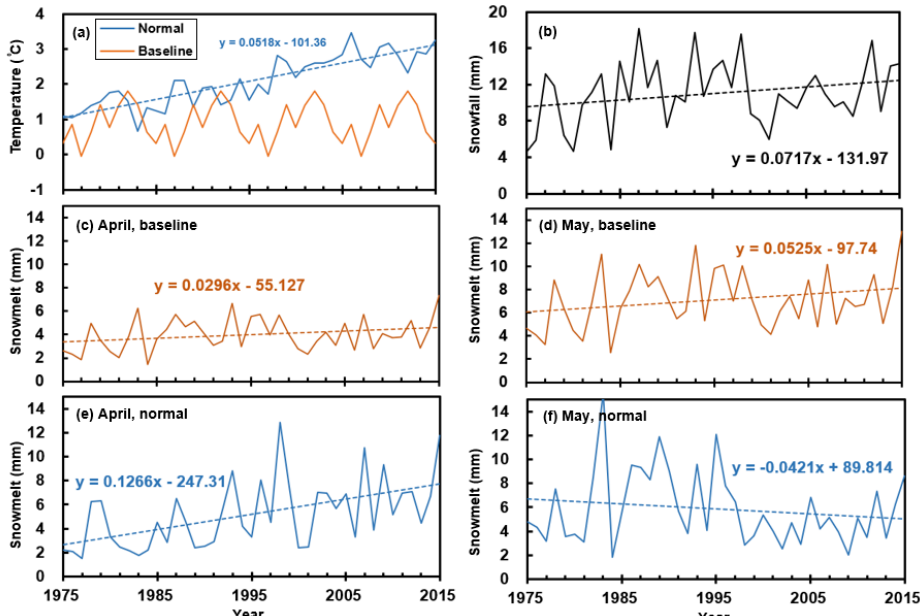
Figure 10. Comparable data and results for the normal and baseline simulations: ( a ) The annual mean air temperature; ( b ) the annual snowfall; ( c , e ) are the snowmelt runoff in April from the normal simulation and baseline simulation, respectively; ( d , f ) are the snowmelt runoff in May from the normal simulation and baseline simulation, respectively.